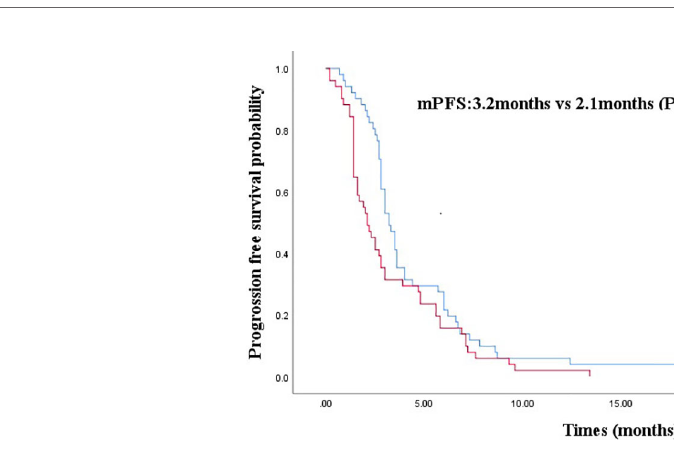
FIGURE 1 | Comparison of progression-free survival in irinotecan group and third-line progression-free survival in